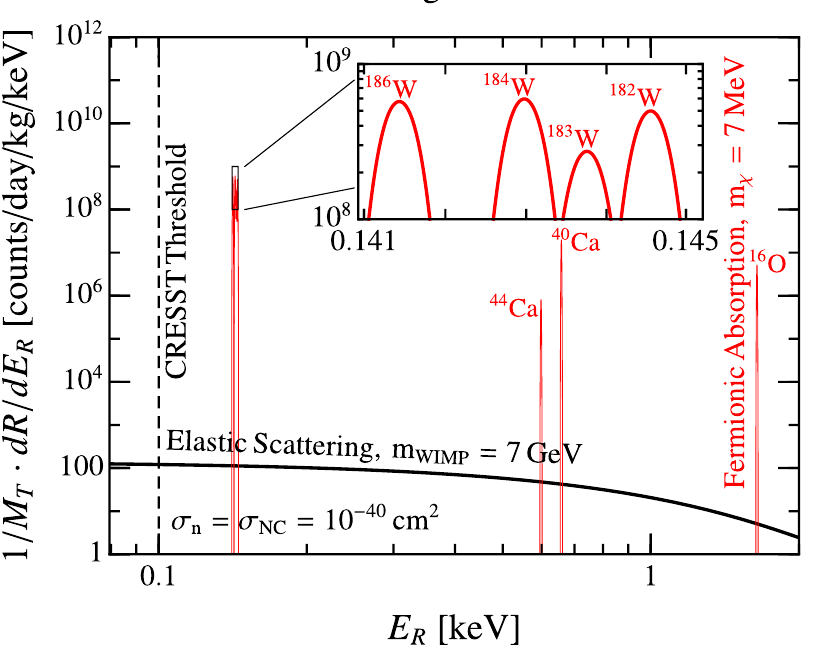
Figure 2 . Di(cid:11)erential scattering rate per recoil energy per detector mass at CRESST [72] from fermionic absorption of a m (cid:31) = 7 MeV dark matter with (cid:27) NC = 10 (cid:0) 40 cm 2 . Also shown is the elastic scattering rate for a WIMP with mass m WIMP = 7 GeV and spin-independent cross section per nucleon (cid:27) n = 10 (cid:0) 40 cm 2 , along with the CRESSTIII nuclear recoil threshold at 100 eV. The (cid:12)gure inset zooms in on the bunched peaks corresponding to the four isotopes of